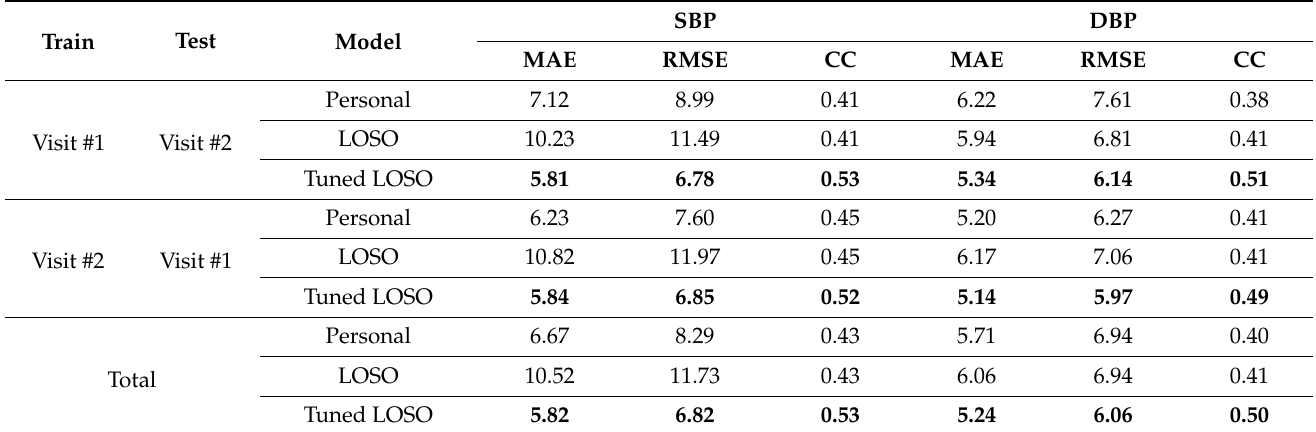
Table 5. Mean MAE, RMSE, and CC values of inter-visit test analysis.